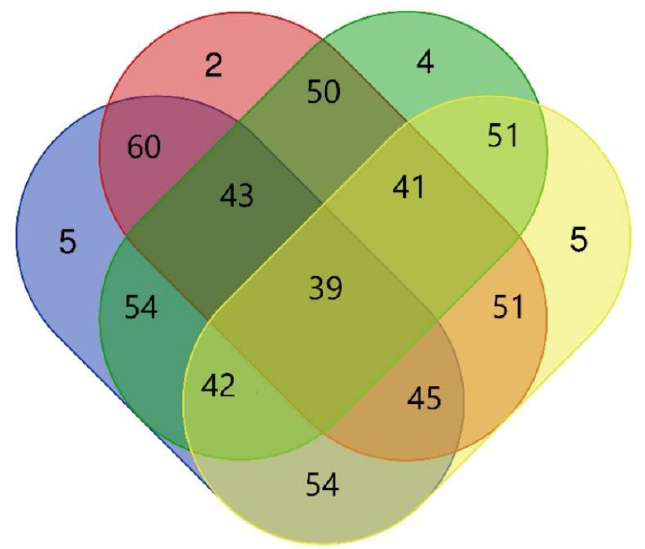
Figure 2. Venn diagram showing the species richness and overlap of insect species collected using sticky traps. The data from different study sites are combined. Different colors show: blue — living Picea abies ; pink — dead P. abies ; green — living Larix sp.; and yellow — dead Larix sp.